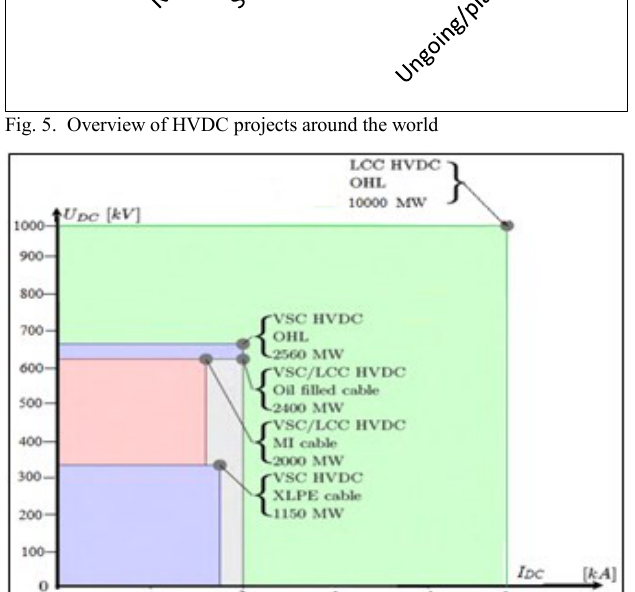
Fig. 6. Available ratings of HVDC systems (U DC refers to voltage per pole, and I DC is the current rating, in a bipolar setup, P=2U DC I DC